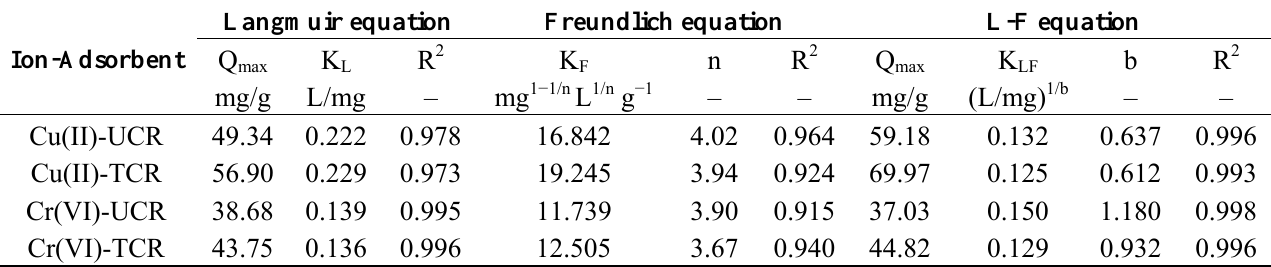
Table 2. Equilibrium parameters for the adsorption of Cu(II) and Cr(VI) onto coffee residues (UCR,